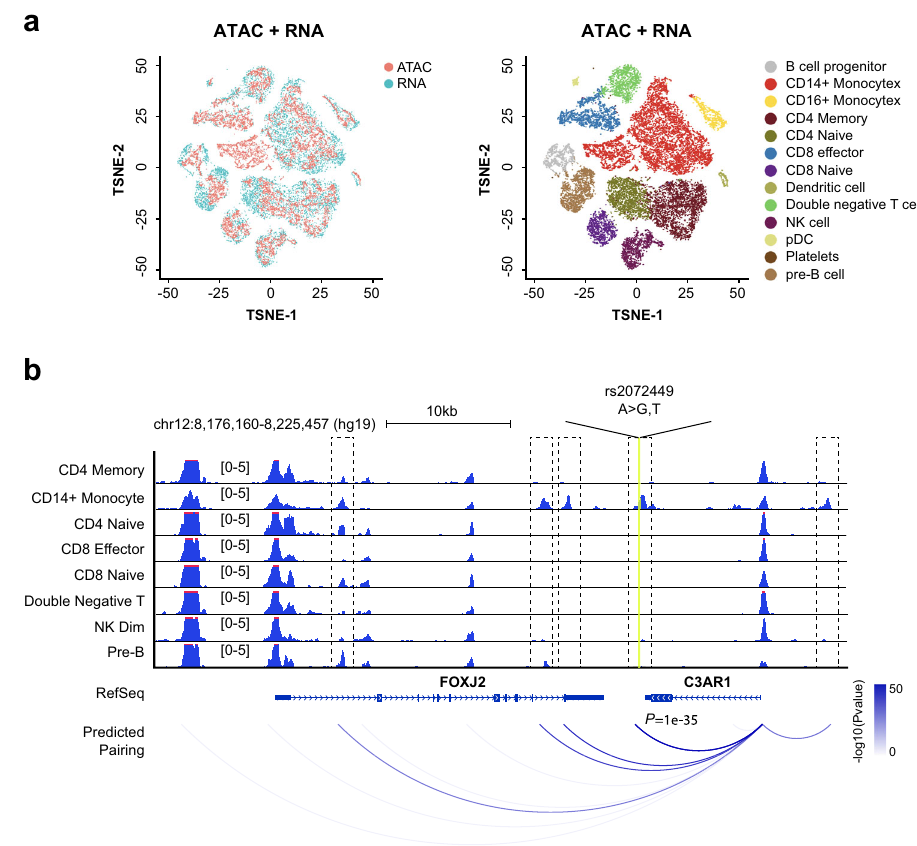
Fig. 2 SnapATAC facilitates integration of single-cell ATAC-seq and RNA-seq data to link enhancers to putative target genes. a Joint t-SNE visualization of scATAC-seq and scRNA-seq datasets from peripheral blood mononuclear cells (PBMC). Cells are colored by modality (left) and predicted cell types (right). b Cell-type-speci fi c chromatin landscapes are shown together with the association score between gene expression of C3AR1 and accessibility at its putative enhancers (logistic regression coef fi cient p -value; Methods section). Dash lines highlight the signi fi cant enhancer – promoter pairs. Yellow line represents the SNP (rs2072449) that is previously identi fi ed to be associated with C3AR1